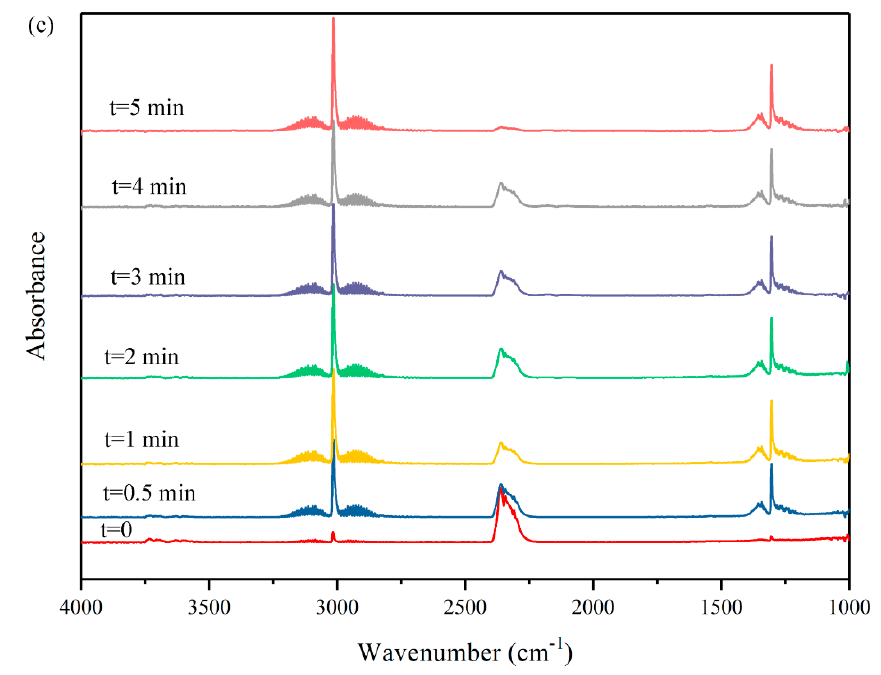
Figure 6. DRIFTS spectra obtained over the reduced NZTA (2) in the sequential DRIFTS experiment of CH 4 -CO 2 -CH 4 at 500 °C ( a ) first CH 4 inject ( b ) subsequent CO 2 inject ( c ) subsequent CH 4 inject.